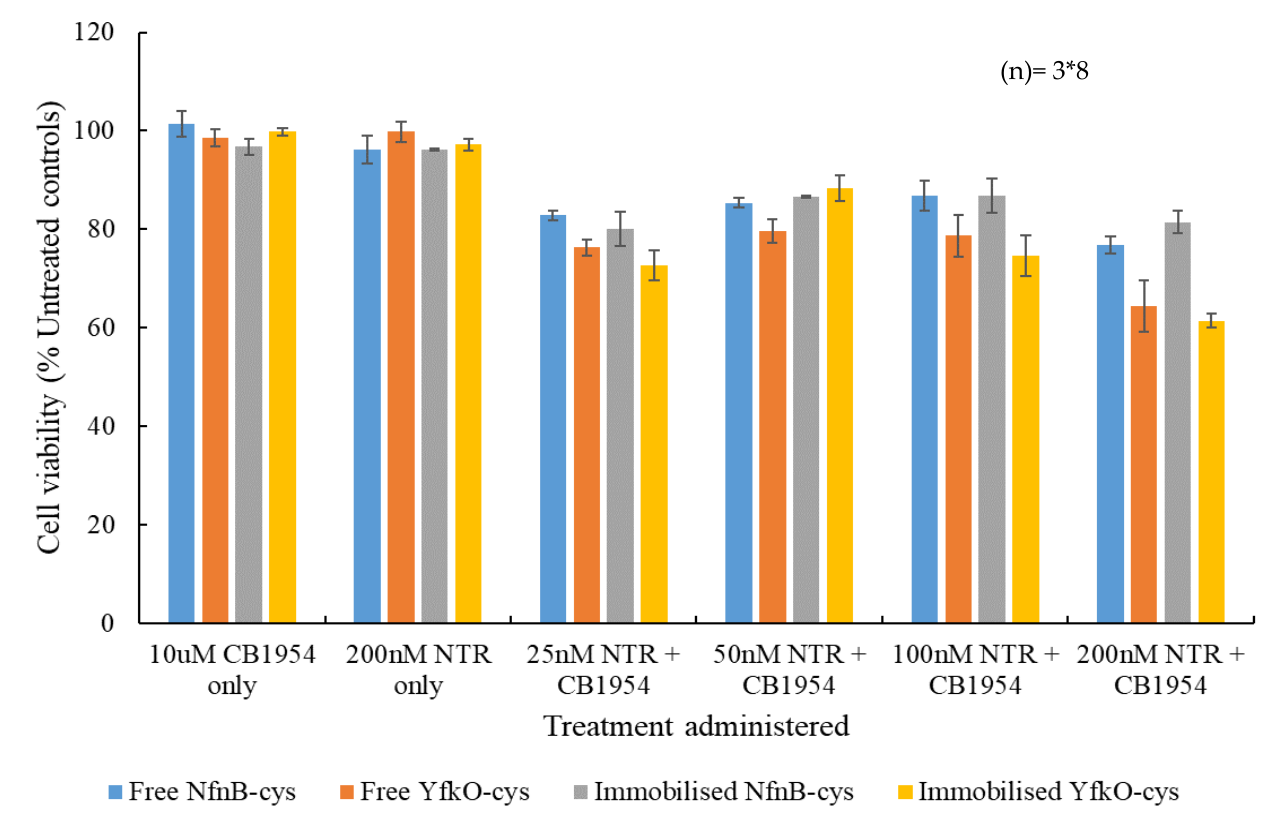
Figure 7. Percentage cell survival relative to untreated control cells of SK-OV-3 cells after a 4 h incubation with prodrug only, enzyme only and increasing concentrations of either free or immobilised NfnB-cys or YfkO-cys (25–200 nM) in presence of CB1954 (10 µM). All data points are taken from the averages of at least three repeats and the error bars represent the standard deviation. Data points were analysed for their statistical significance using F-test with a p value of (>0.005), error bars are ±1 standard deviation, and ( n ) is the number of repeats each data point had.